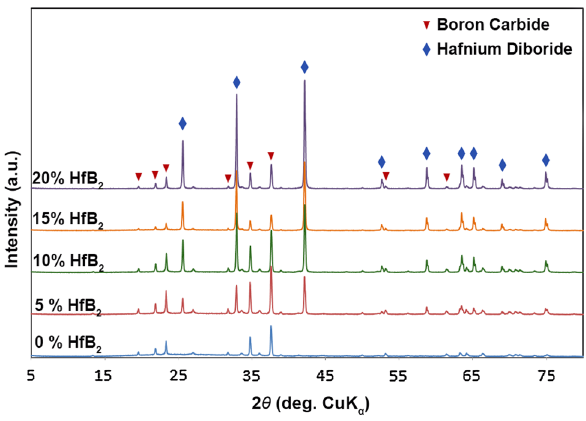
Fig. 1 X-ray diffraction data for composite samples showing relative peak